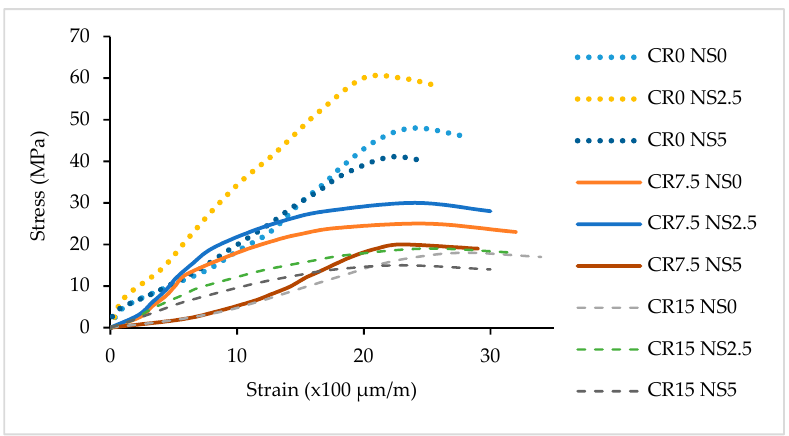
Figure 10. Stress-strain of NS-CRM mixes at 28 days.